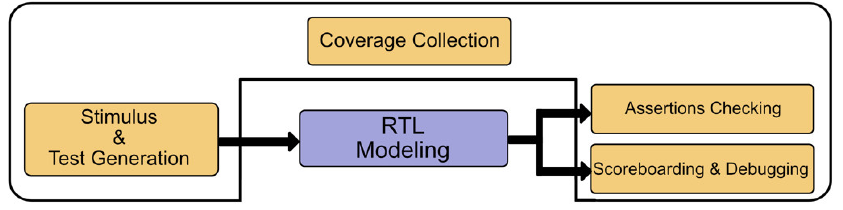
Figure 2. Top-level view of the stages involved in a functional verification process.